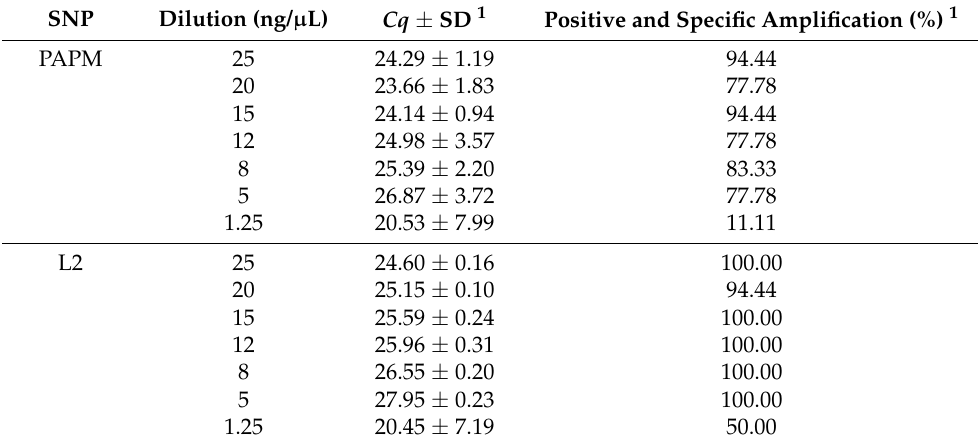
Table 6. LOD 6 determination in PAPM and L2.